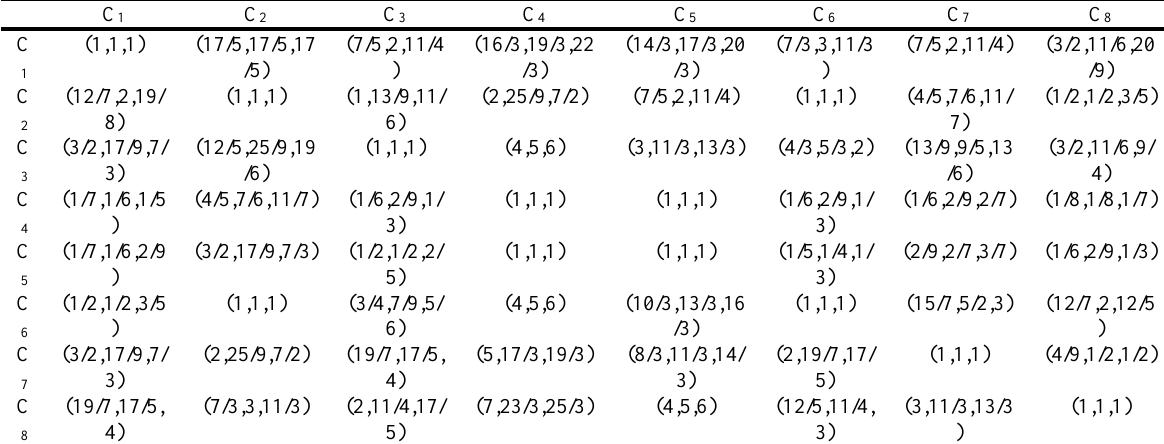
Table 13. Pair wise contribution matric for the factors of “Customer Chain”.